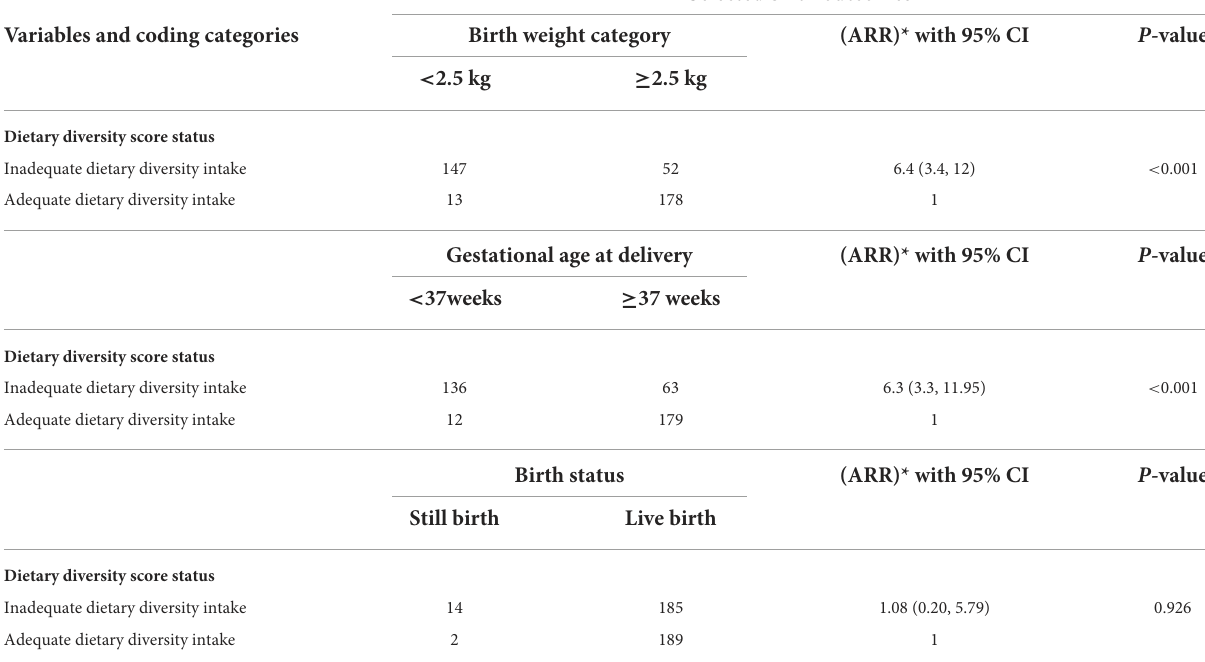
TABLE 6 Log-binomial regression analysis result of pregnancy and birth outcomes of study participants by their dietary diversity score status, east Gojjam zone, northwest